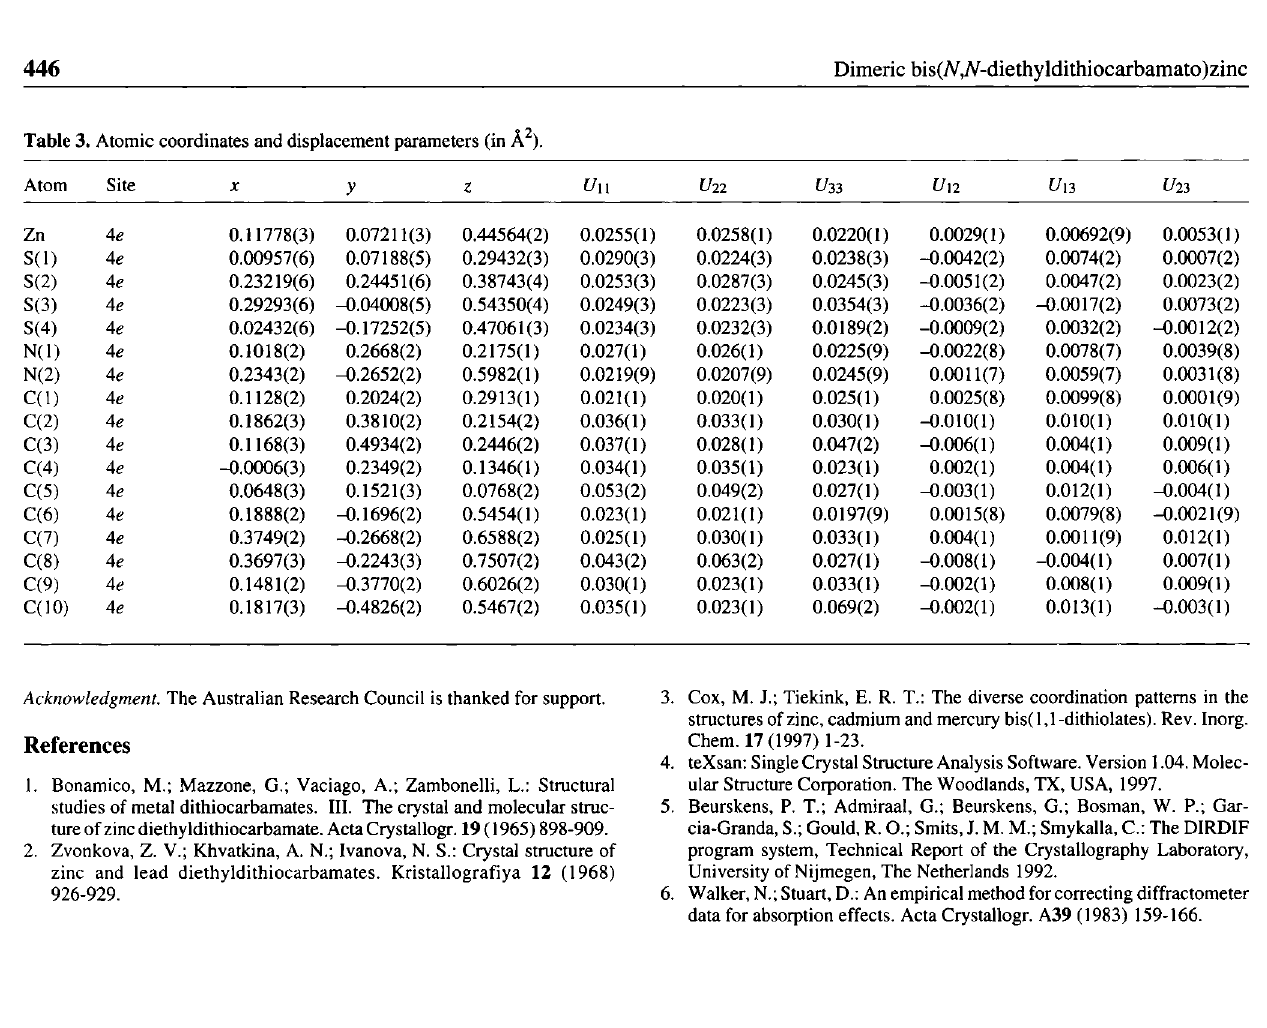
Table 3. Atomic coordinates and displacement parameters (in Ä 2